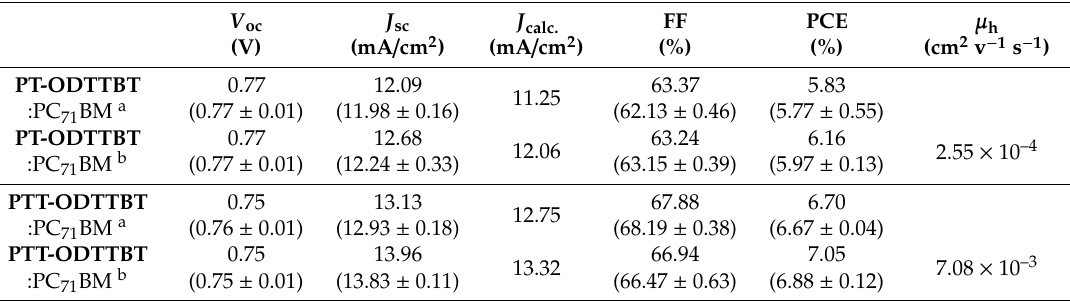
Figure 2. ( a ) J-V characteristics of blended films with and without DIO and ( b ) the corresponding EQE curves. Figure 3. ( a ) J-V characteristics of the hole-only devices and ( b ) field-dependent hole mobilities of polymer:PC 71 BM (1:2 w/w ) blend films calculated for the hole-only devices by fitting J - V curves in the SCLC regime. Table 2. Photovoltaic properties of polymer:PC 71 BM-based OPV devices.